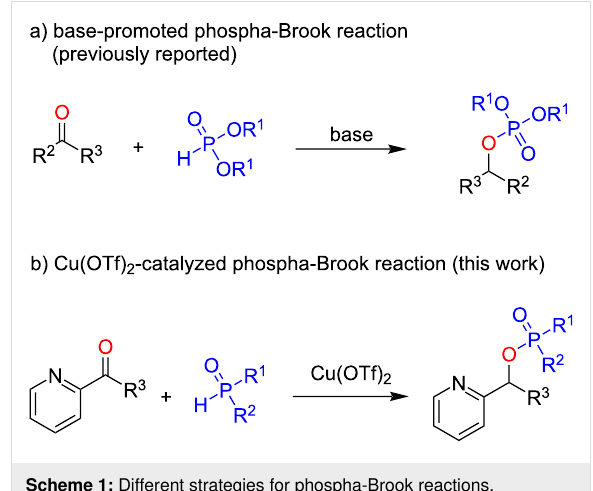
Scheme 1: Different strategies for phospha-Brook